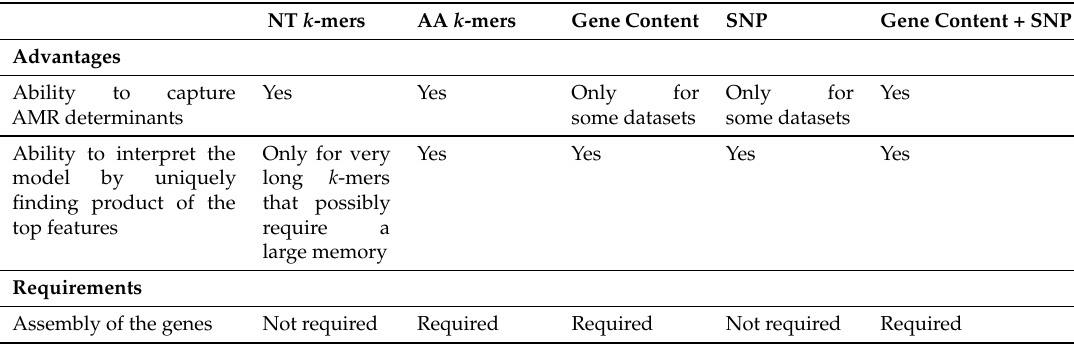
Table 3. A summary of the comparison of different